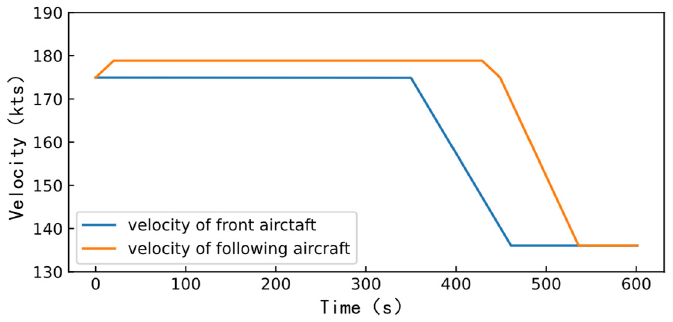
Figure 6. The front and following aircraft velocity profiles.